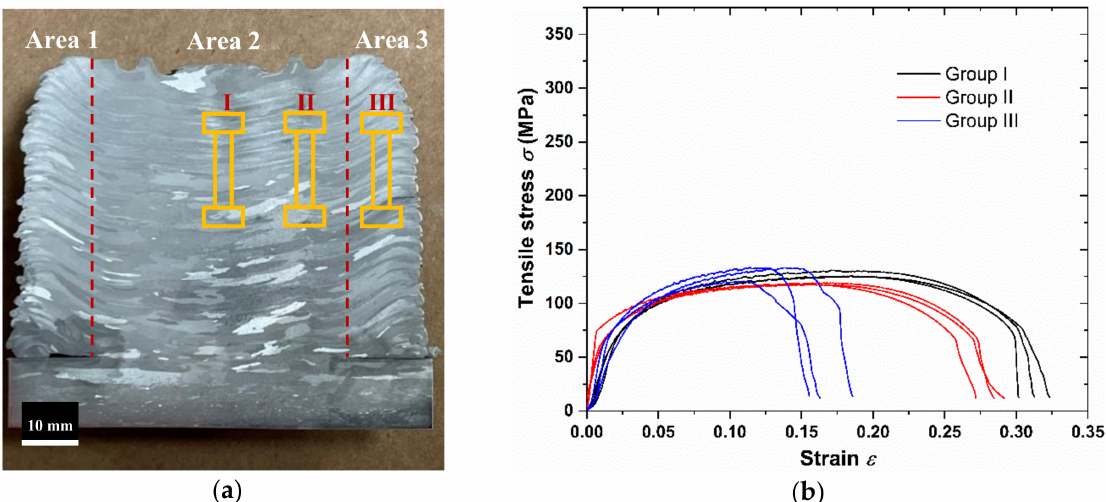
Figure 9. Tensile testing results of a slab from ingot A [6]. ( a ) position of the dog bone samples in the slab: Group I is in the middle, Group II is under the tool protrusion, and Group III is in the flash region. The gauge cross section of the specimen is 2 mm by 2 mm. ( b ) Stress–strain curve of each Group.